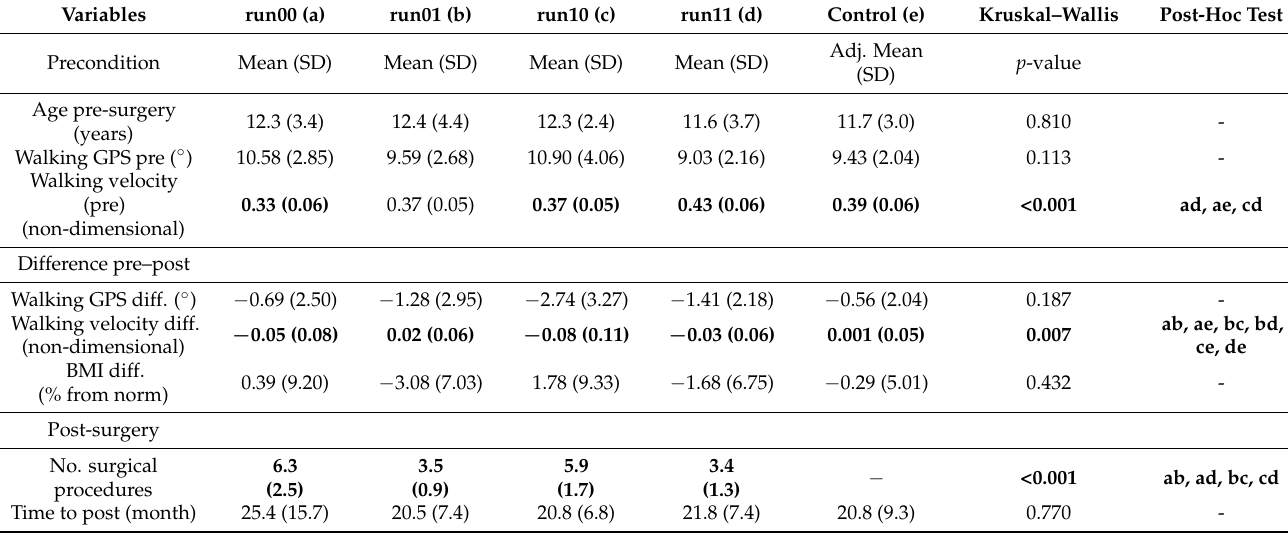
Table 2. Group means, standard deviations (SD), Kruskal–Wallis and post-hoc test